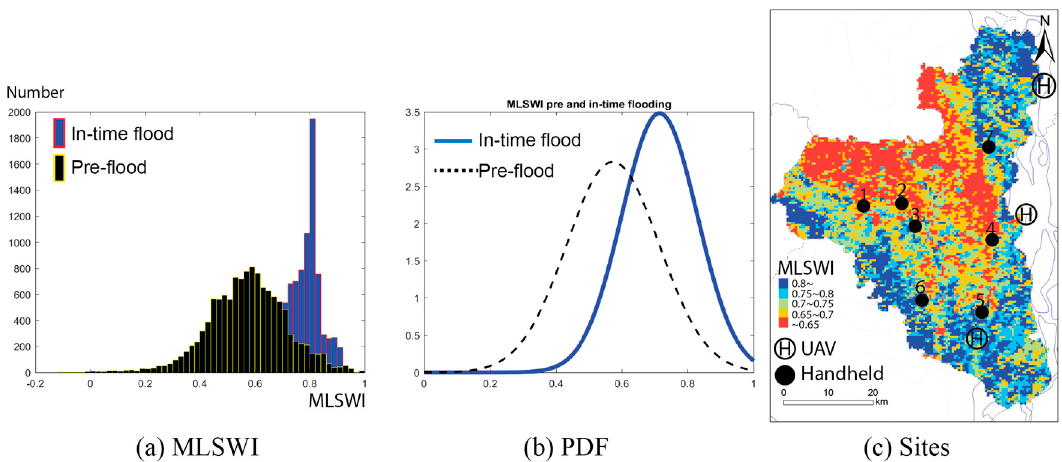
Figure 4. Cross-validated observations of in situ and high-resolution SAR data: ( a ) Comparisons of histogram of distributed MLSWI values before (black bar) and during (blue bar) the 2015 flood in sampling site, Sirajgangj district; ( b ) Comparisons of PDF histogram before (dash line) and during (blue line) the 2015 flood; ( c ) sampling sites, UAV-assisted field investigation (circle of H) and handheld measurement (black points) for ground validation based on the pixel-based classification of MLSWI.